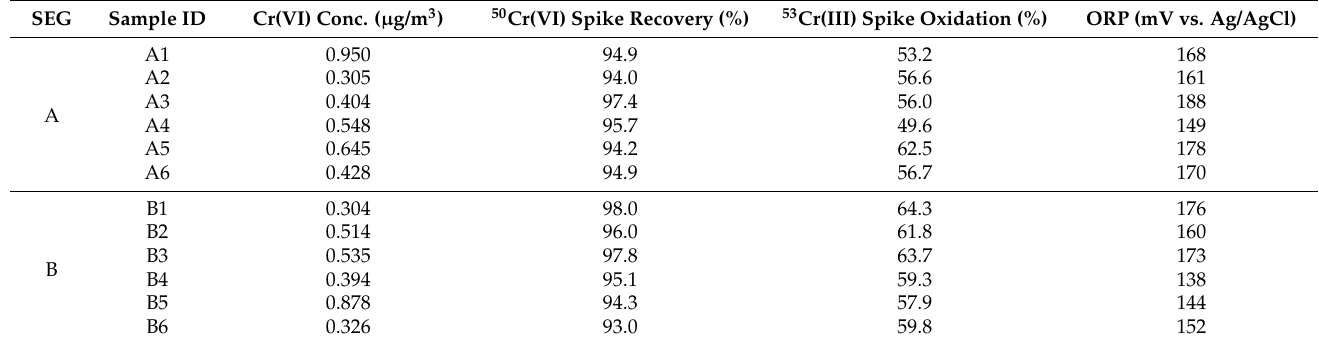
Table 4. Cr(VI) occupational exposure detected with the NIOSH extraction protocol through personal sampling in two SEGs of tanned leather shavers. Data of spikes recoveries/oxidations are presented, together with ORP values determined after extraction and neutralization.